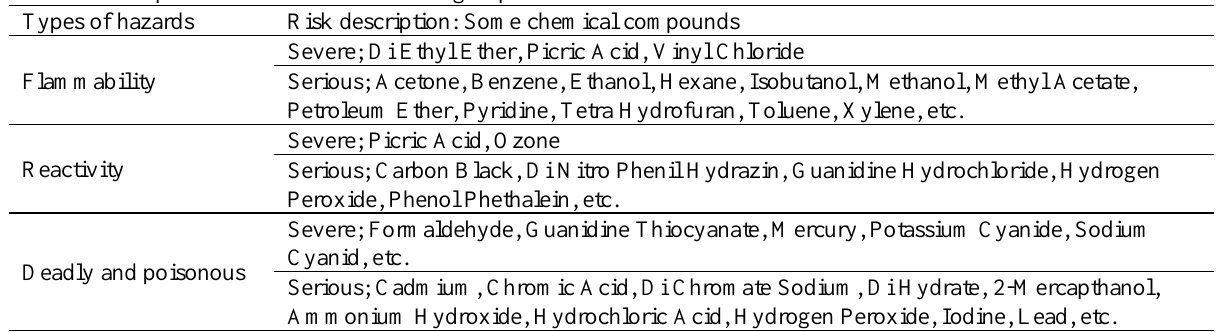
Table 4. Examples of chemicals in different groups of the NFPA classification Types of hazards Risk description: Some chemical